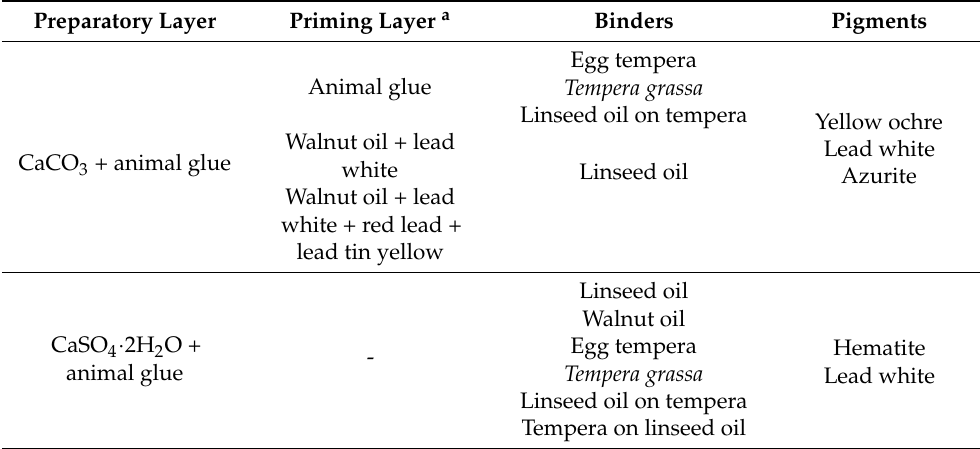
Table 1. Stratigraphy of the mock-up samples realized on a wooden panel. Preparatory